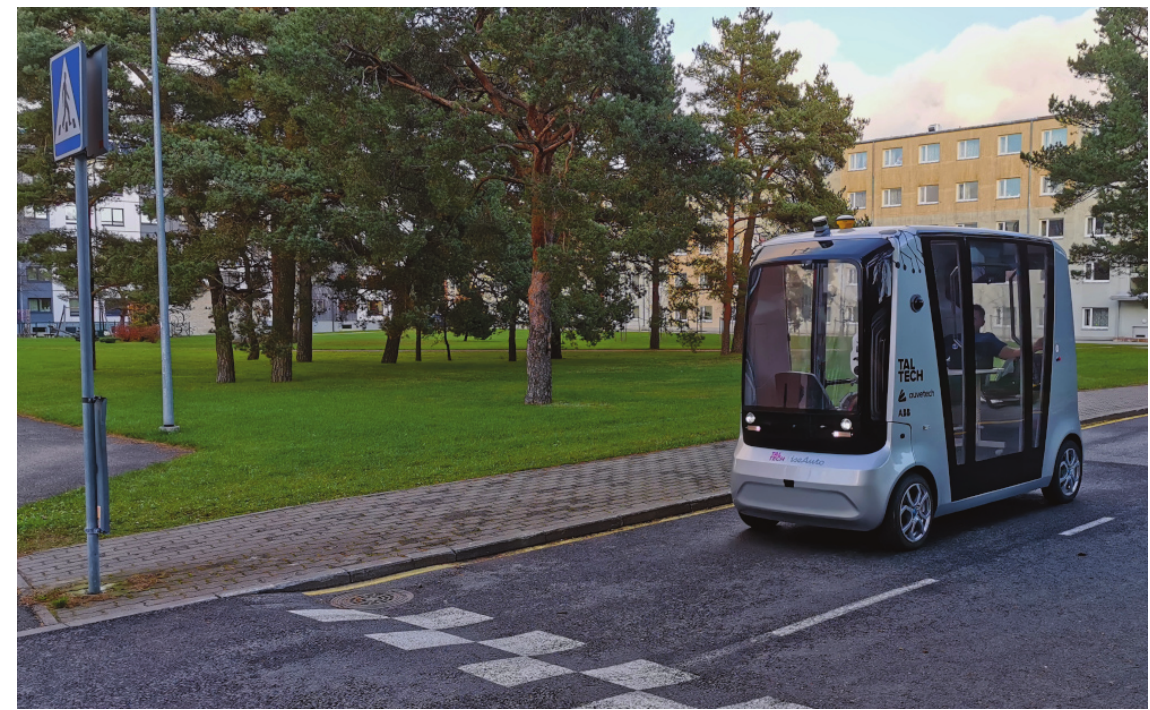
Fig. 1. TalTech iseAuto – an AV